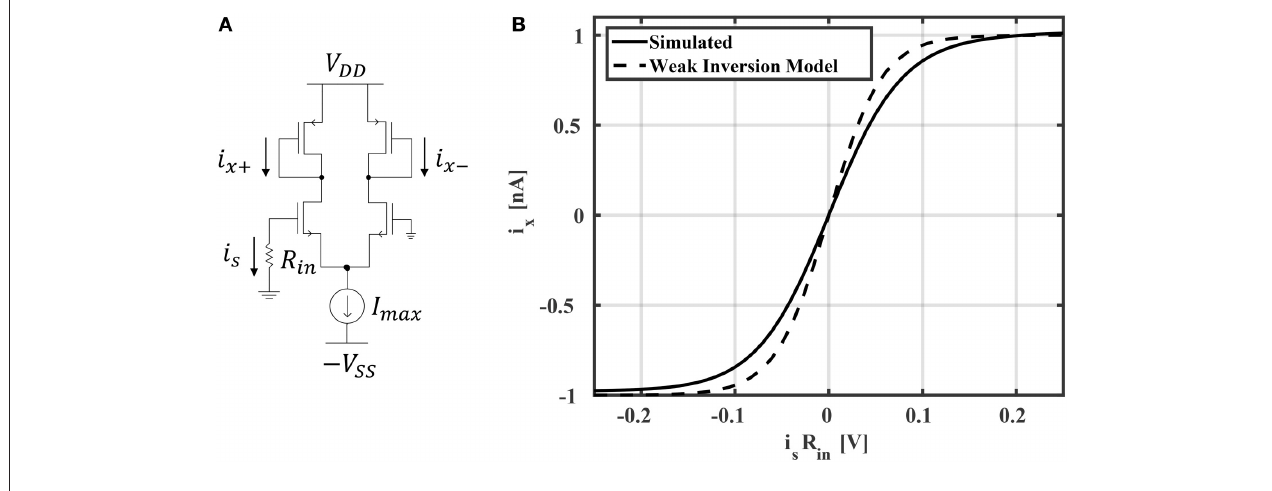
FIGURE 5 | (A) Hyperbolic tangent neuron circuit and (B) its current-voltage relationship.